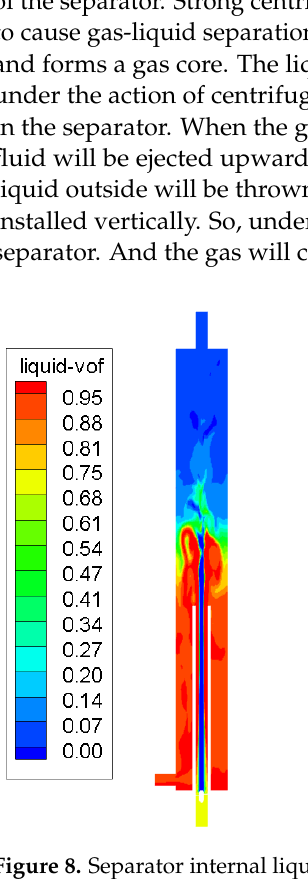
Figure 7. Comparison of experimental and simulated values.